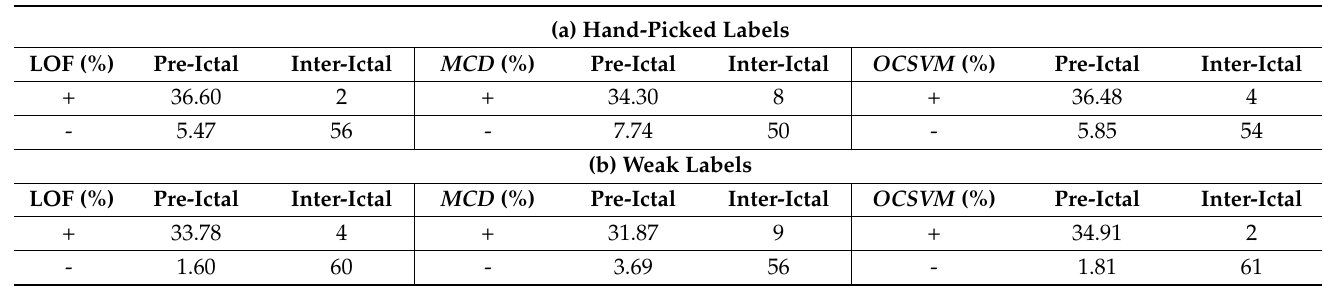
Table 5. Cumulative percentile confusion matrices for the three models across all experimental cases evaluated with ( a ) hand-picked and ( b ) weak